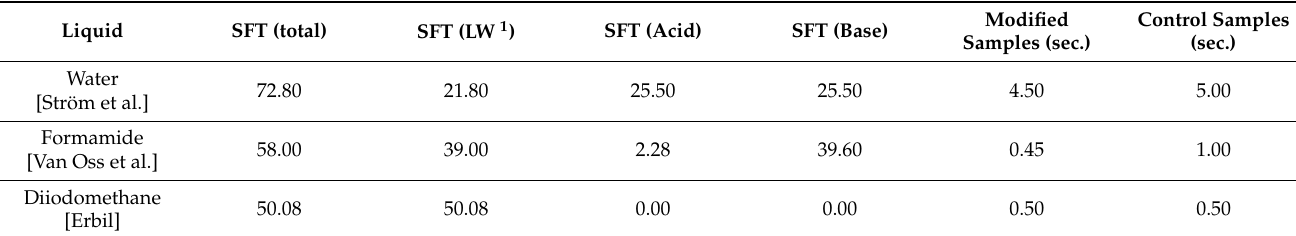
Table 1. Surface tension (SFT) of measuring liquids in mN/m, its components (LW, acid, and base), and time frame for contact angle measurement.